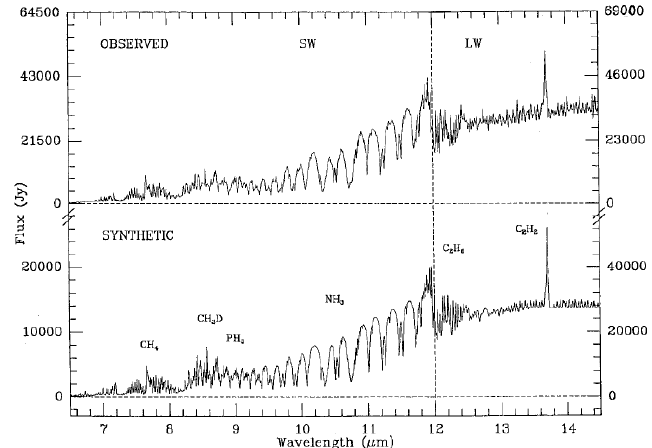
Figure 5. Mean Jupiter spectrum recorded by the SWS instrument on ISO, at 6–14 µ m. The main molecular features of the spectrum are identified (image credits: Encrenaz et al.